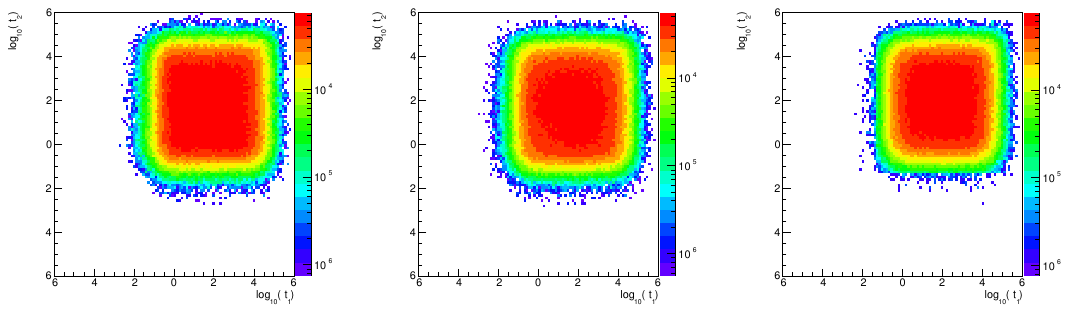
Figure 11 . Distributions for Q 2 p s = 13 TeV.